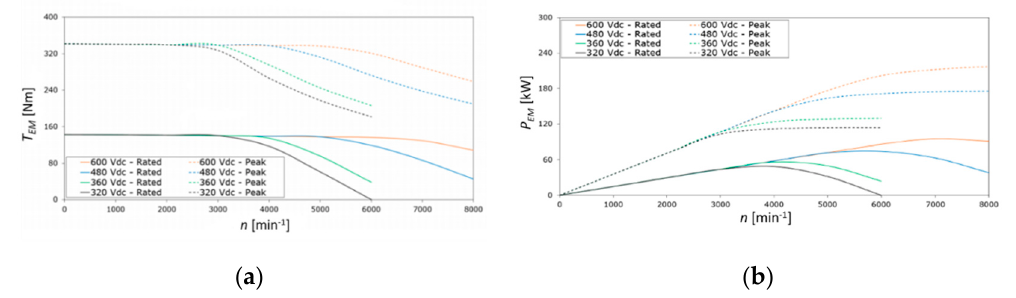
Figure 5. AF 130 electromotor torque curve ( a ), and power curve ( b ) [25]. Table 3. AF130 electromotor data [25].